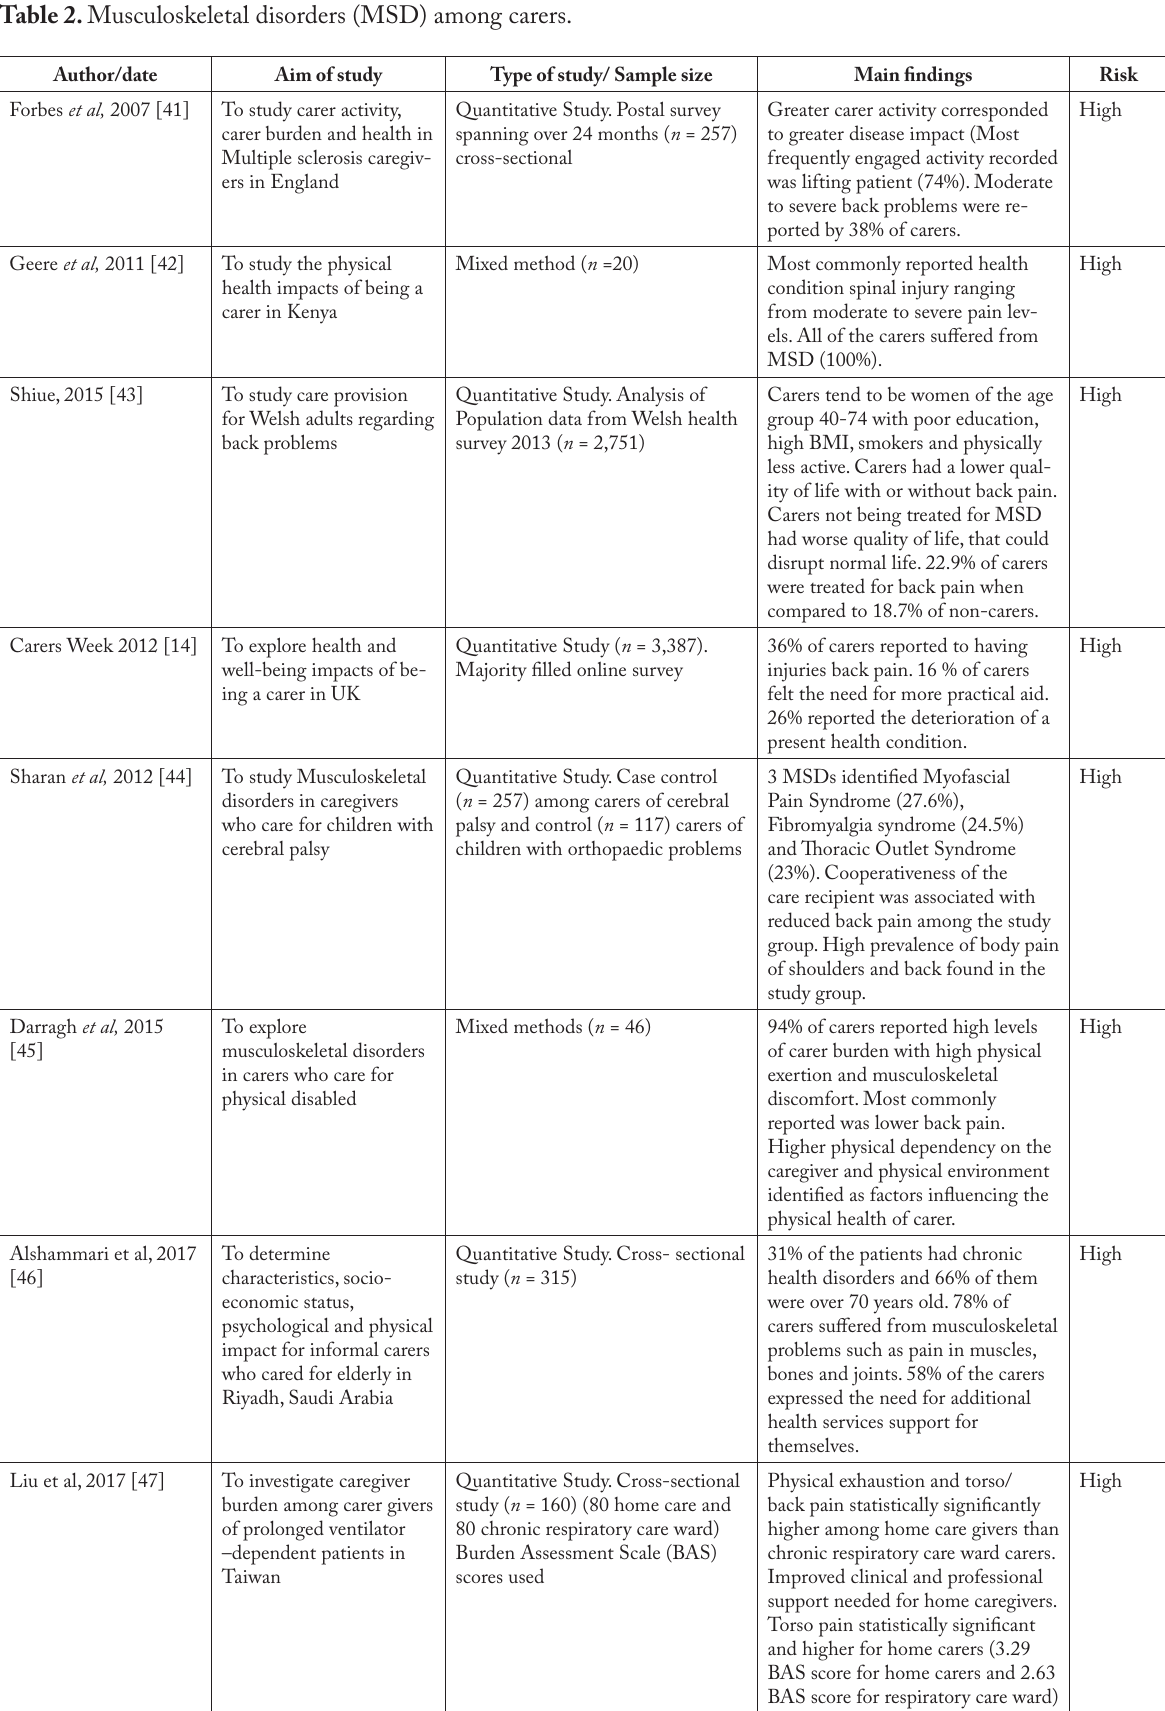
Table 2. Musculoskeletal disorders (MSD) among